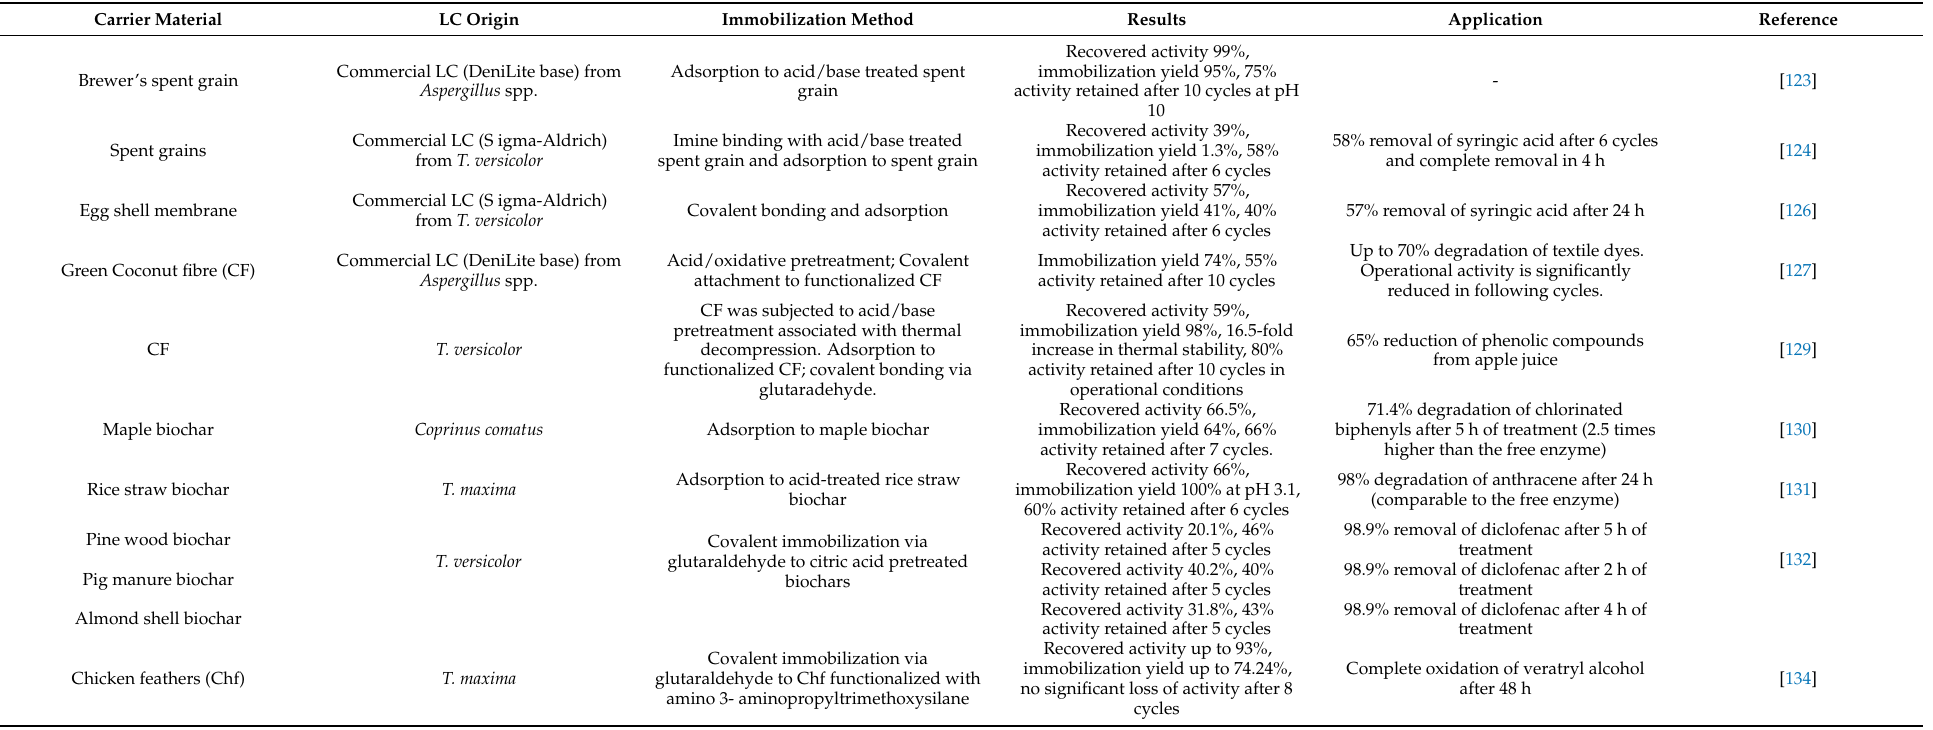
Table 2. Laccase immobilization on sustainable